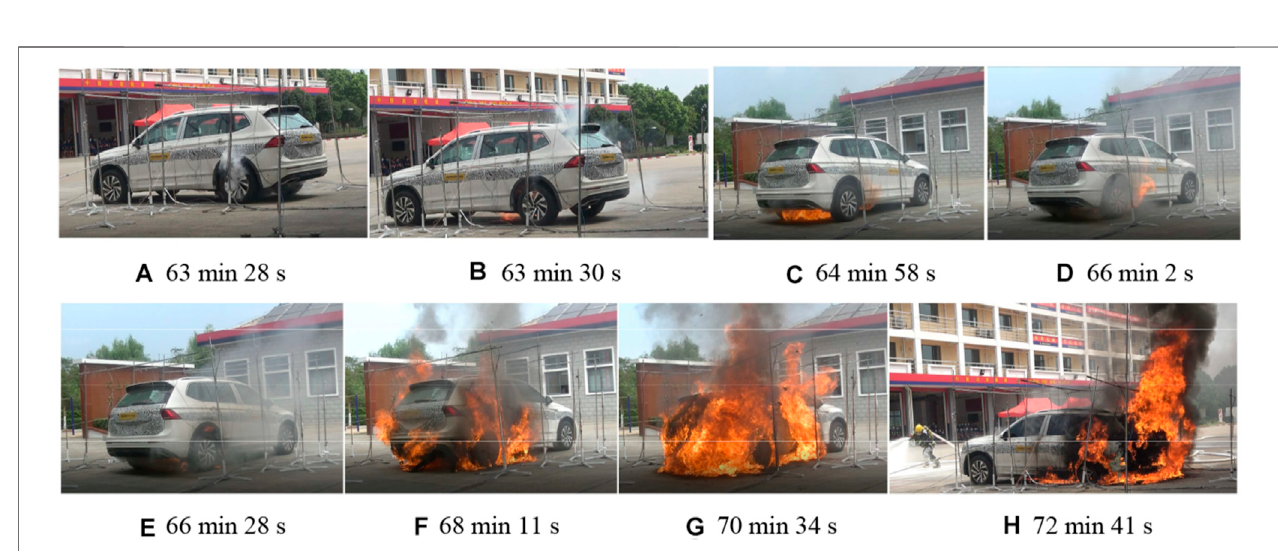
FIGURE 2 | The burning process of PHEV A. (A) 63 min 28 s (B) 63 min 30 s (C) 64 min 58 s (D) 66 min 2 s (E) 66 min 28 s (F) 68 min 11 s (G) 70 min 34 s (H) 72 min 41 s.